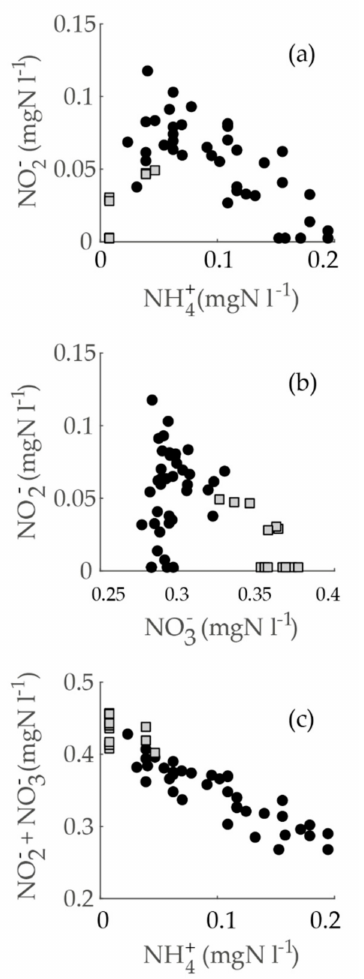
Figure 7. A scatterplot of inorganic nitrogen species in the sampling campaign. Groups are divided by the seasonality type of the sampling location; black dots indicate a summer maximum (in the locations of Pitkäkoski WTP, Sport Center M, and Gas Station R); grey squares indicate a winter maximum (Gas Station K). The graphs show ( a ) ammonium vs. nitrite, ( b ) nitrate vs. nitrite, and ( c ) ammonium vs. nitrite +